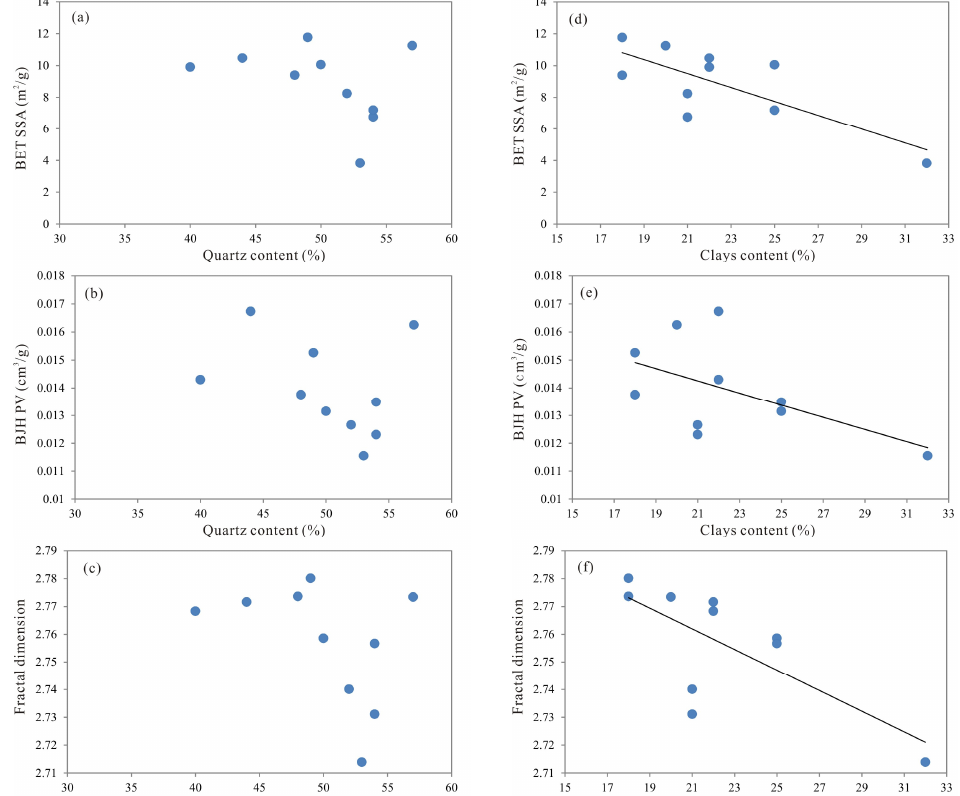
Figure 8. Effect of clay minerals and quartz content on pore structure parameters (BET SSA, BJH PV and fractal dimension) in the shale samples. ( a ) Relationship between quartz content and BET SSA; ( b ) Relationship between quartz content and BJH PV; ( c ) Relationship between quartz content and fractal dimension; ( d ) Relationship between clays content and BET SSA; ( e ) Relationship between clays content and BJH PV; ( f ) Relationship between clays content and fractal dimension.